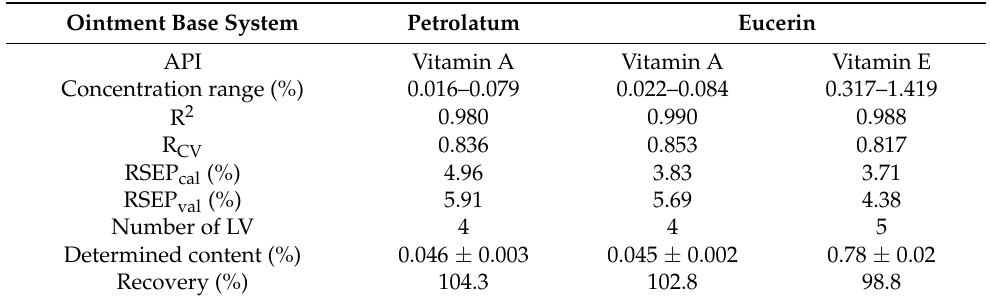
Table 1. Parameters of PLS models and results of API determination in commercial ointments ( n = 8).